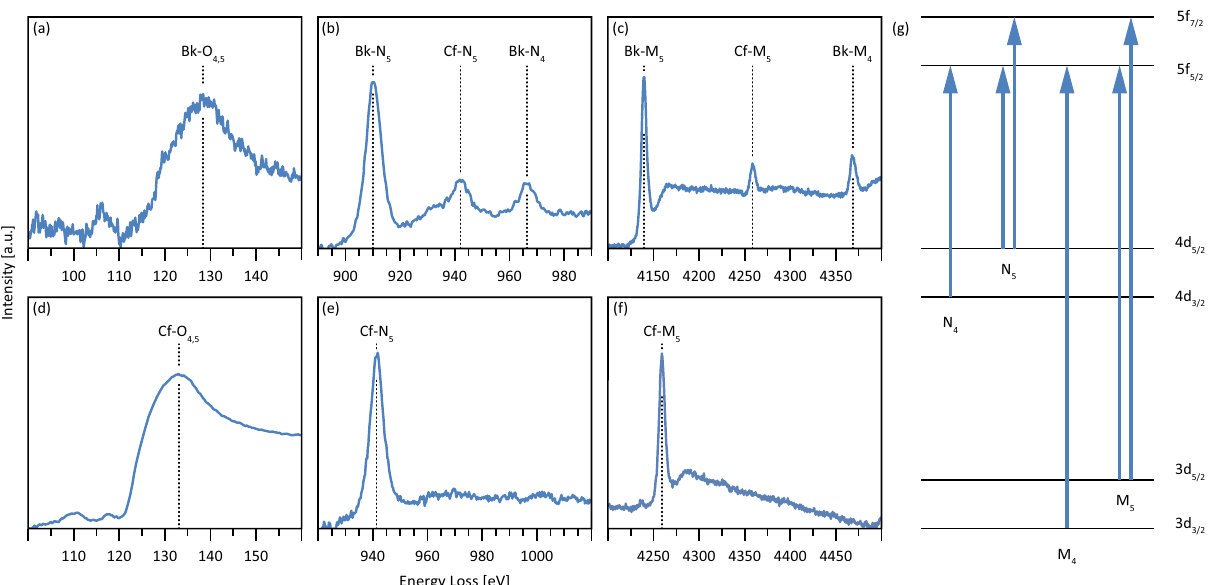
Fig. 3 Electronic structures of Bk and Cf compounds. EELS spectra showing the a O 4,5 , b N 4,5 , and c M 4,5 edges of Bk and the d O 4,5 , e N 4,5 , and f M 4,5 edges of Cf. The spectra of Bk have contributions from Cf that formed by radioactive decay. Please note that the scaling of the energy loss axis differs depending on whether O 4,5 , N 4,5 , or M 4,5 edges are shown. It is, however, consistent when comparing speci fi c edges of the two elements. g Simple band diagram showing the transitions corresponding to the different white